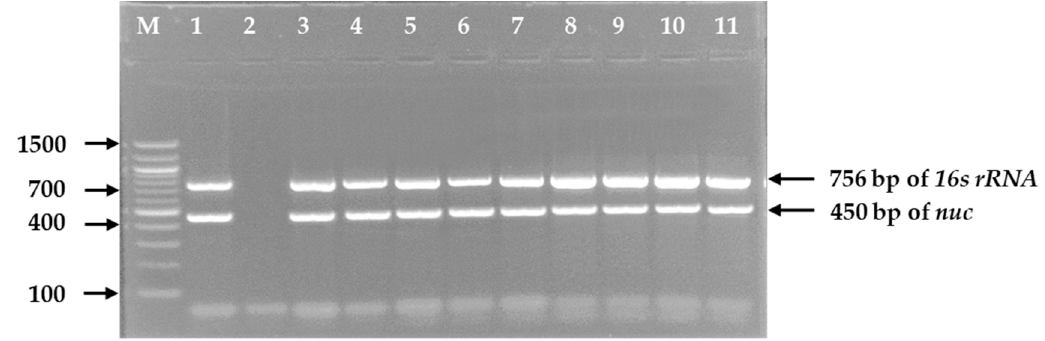
Figure 1. PCR amplified products of 756 bp of 16s rRNA gene of Staphylococcus spp. and 450 bp of nuc gene of Staphylococcus aureus in 1.5% agarose gel electrophoresis and ethidium bromide staining. Legends: M = DNA marker (100 bp), Lane 1 = Positive control of S. aureus , Lane 2 = Negative control, Lane 3–11 = Tested S. aureus isolates.